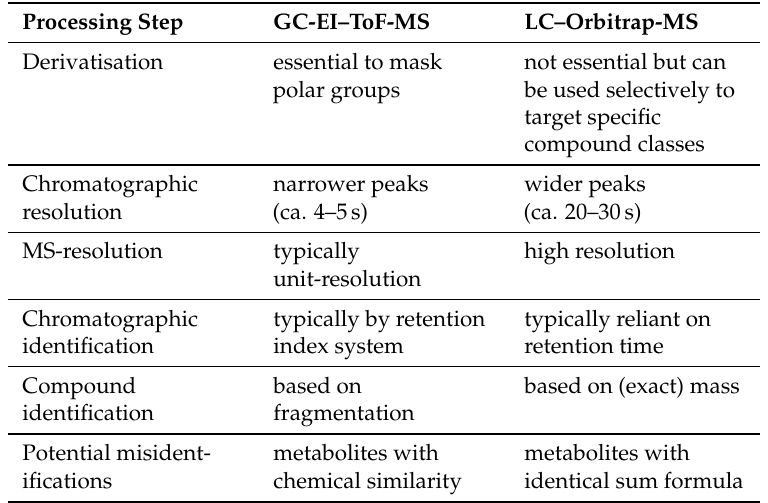
Table 1. Identification parameters for common setups in metabolomics